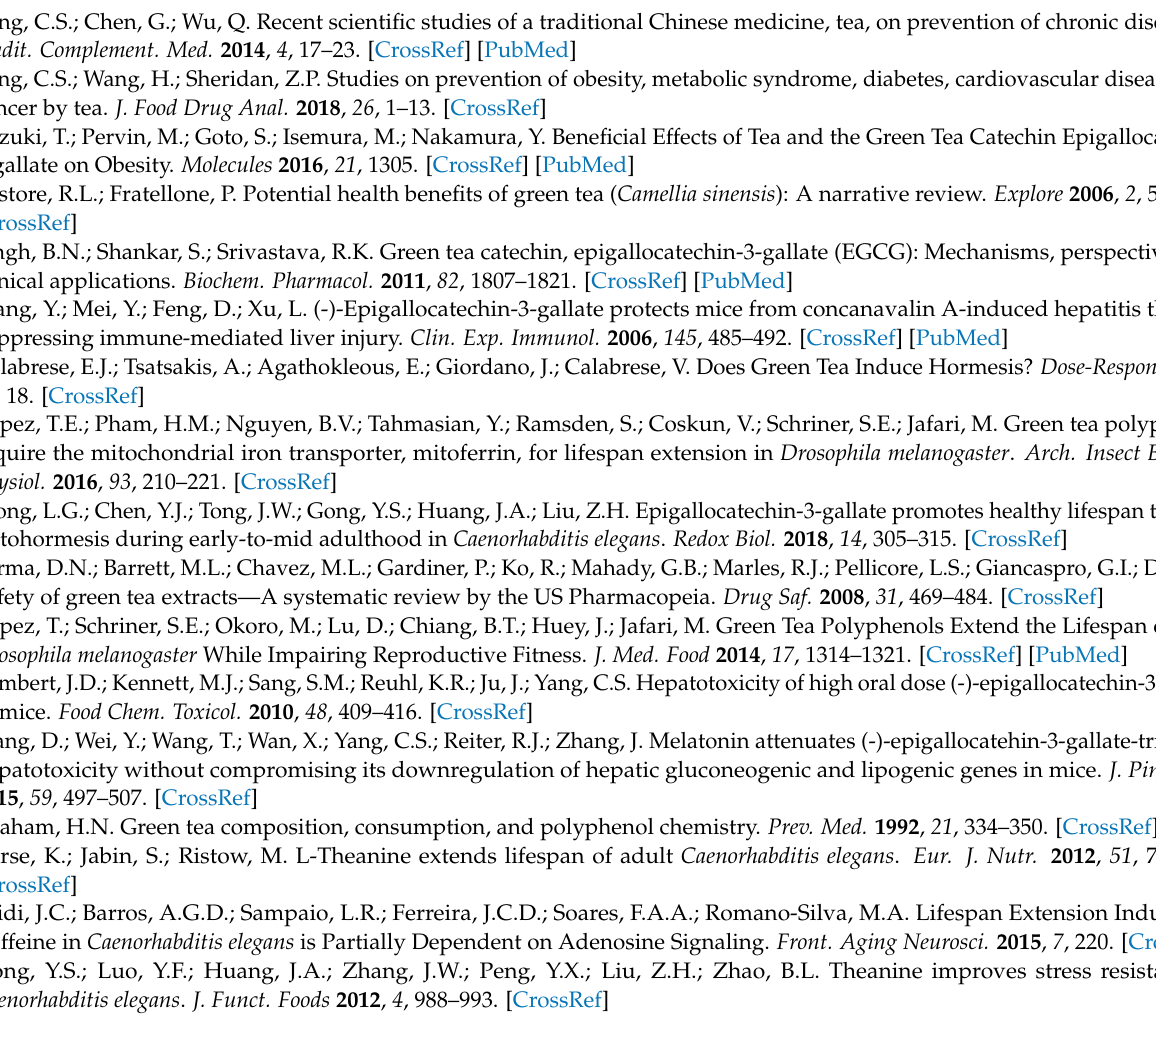
related to Figure 2A–F; Table S3: related to Figure 4C,D; Table S4: